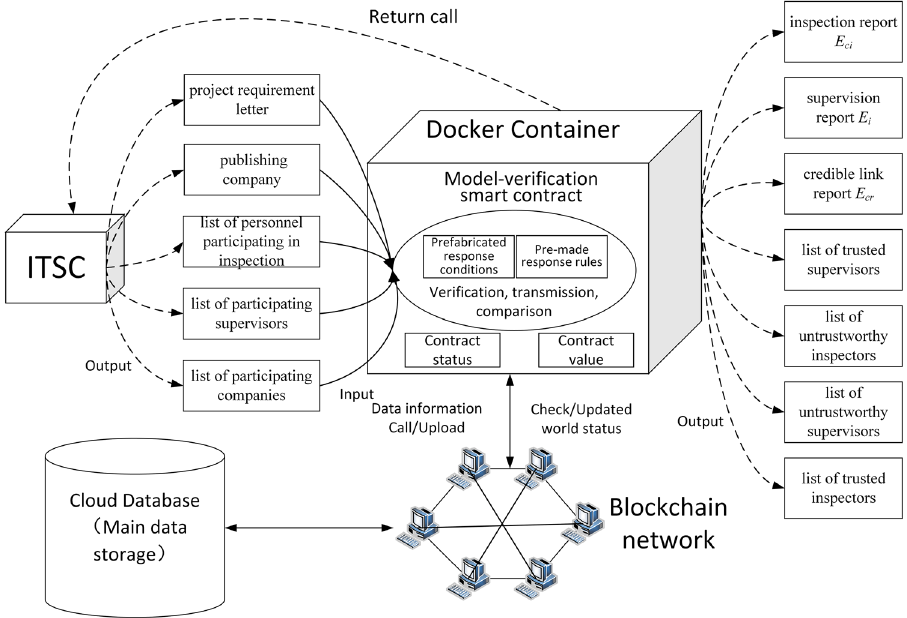
Figure 4. Logic diagram of the model-verification smart